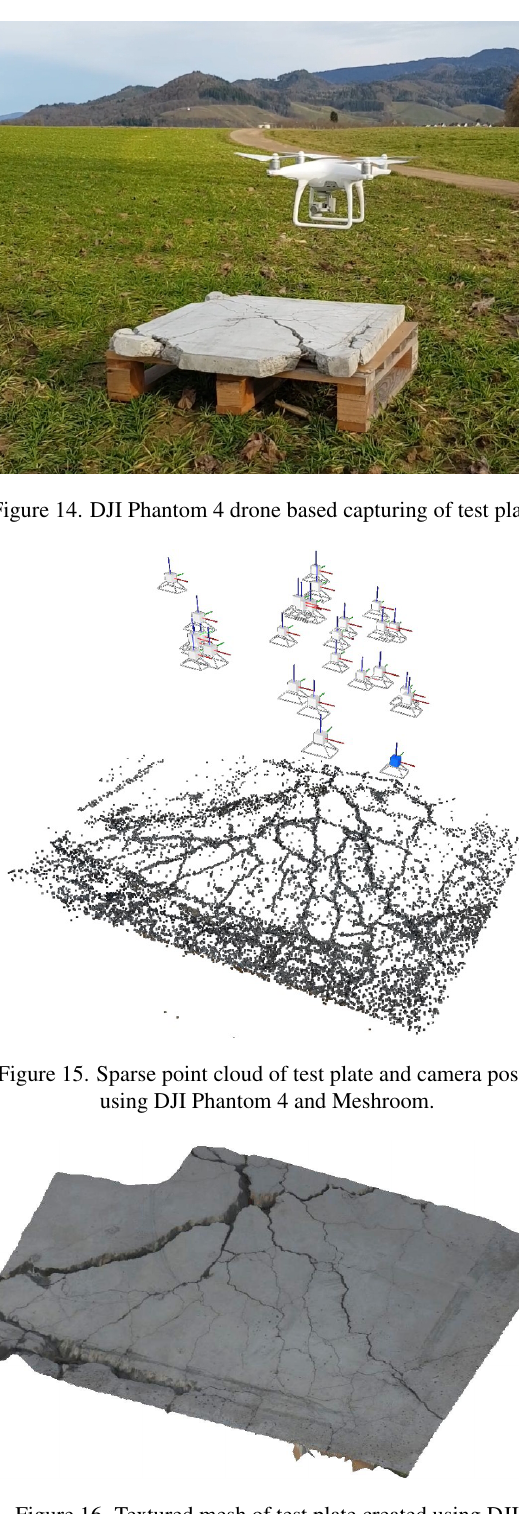
Figure 16. Textured mesh of test plate created using DJI Phantom 4 and Meshroom.